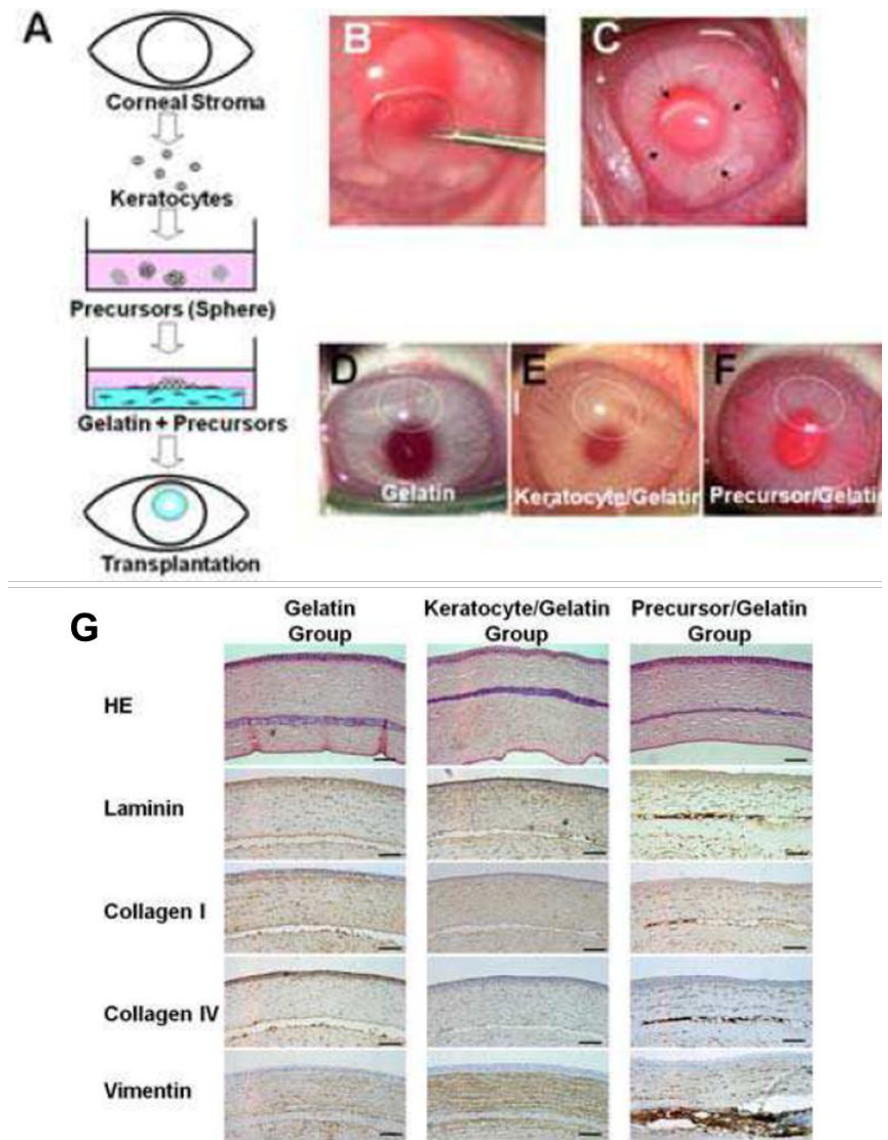
Figure 2. Assessment of the in vivo biocompatibility of cultured corneal stromal cells with GA crosslinked gelatin. ( A ) Culture of primary corneal stromal cell spheroids seeded upon a GA crosslinked gelatin hydrogel; ( B , C ) Implantation of construct within intra-stromal pockets in the rabbit cornea; ( D , E , F ) Visual appearance of constructs 4 weeks after implantation showing; ( D ) Gelatin; ( E ) Keratocyte and gelatin; and ( F ) Keratocyte precursor and gelatin; ( G ) Histological analysis of the implants 4 weeks after implantation showing no immune cell infiltration of the gelatin implants in any group. Keratocyte precursor cells showing more intense staining for laminin, type I and type IV collagen, and vimentin, Scale bar = 100 μm; ( H ) Immunolocalization of CD34 positive or nestin positive cells within the transplanted keratocytes precursor gelatin implants 4 weeks after transplantation. Rhodamine (red colour) shows the transplanted labelled corneal keratocyte precursors in the gelatin hydrogels, and FITC (green colour) shows the CD34- or nestin- positive cells. Scale bar = 100 μm. Courtesy of Mimura et al. [70] and Molecular Vision. Copyright by Mimura (2008). The work was originally published in